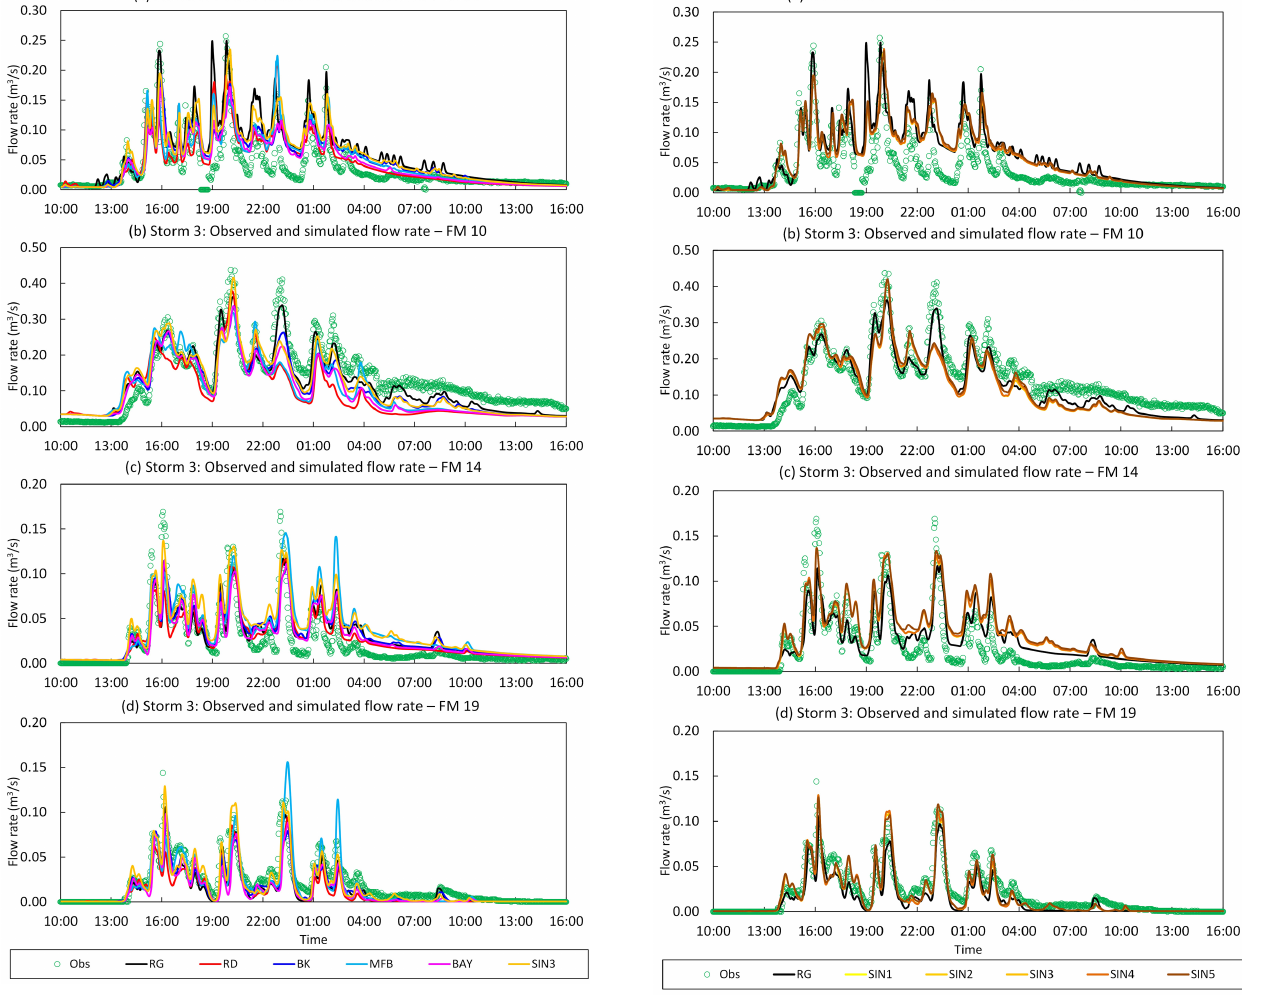
Figure 9. Observed flows vs. simulated flows with SIN1–SIN5 rain- fall inputs at selected flow gauging sites of Portobello catchment during Storm 3. Selected gauging sites: FM14: upstream end of a small branch of the sewer system (top panels); FM19: downstream end of the catchment (bottom panels). The location of the selected monitoring sites is shown in Fig.